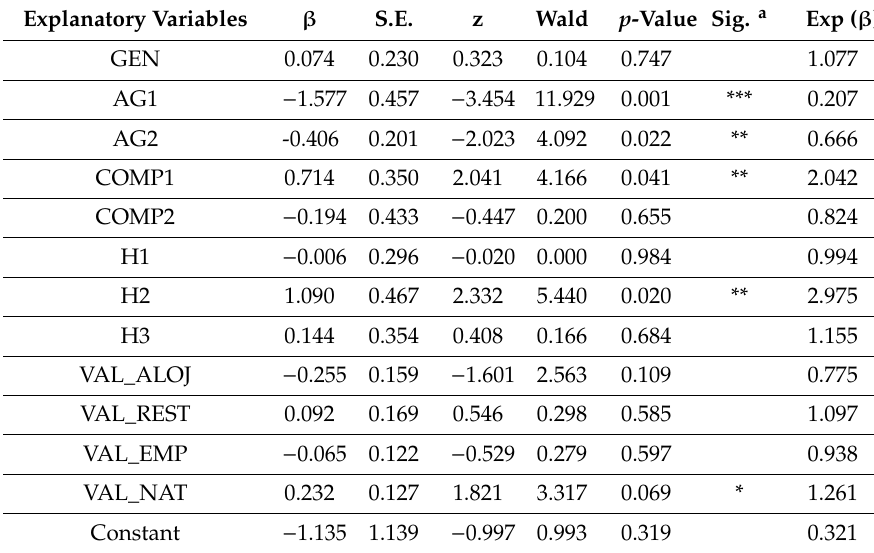
Table 4. Estimation of the binary logistic regression model (1) for foreign tourists. Explanatory